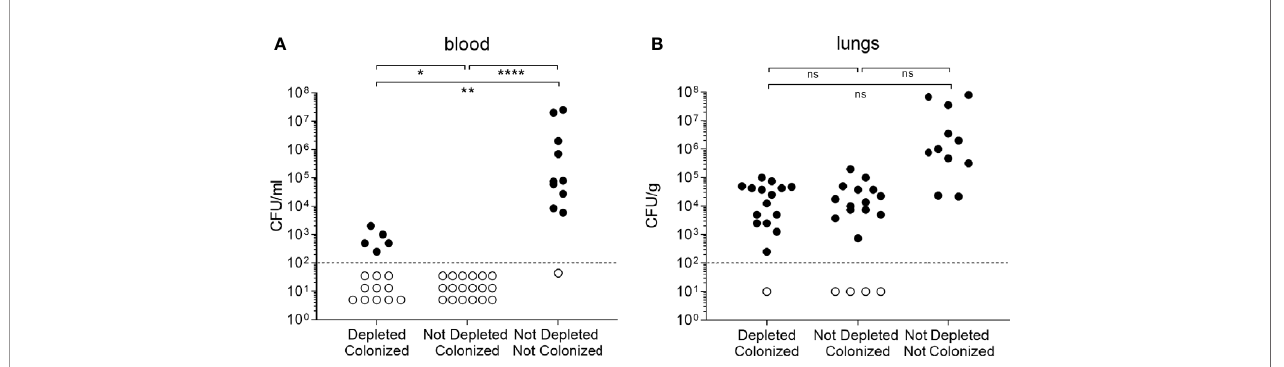
FIGURE 7 | B cell depletion effect on colonization. (A) CFU measured from blood of C57Bl/6 mice 24 h after intranasal infection with 6B strain. Mice were divided in three groups depending on the pre-infection treatment received: depleted colonized (n=16), not depleted colonized (n=18) and not depleted not colonized (n=11). At day 32, pneumococcal pneumonia was induced infecting intranasally the mice with 6B strain. (B) CFU measured from the same experiment in lungs homogenates. Error bars indicate standard deviations and Fisher ’ s exact test was used for statistical analysis (*P < 0.05, **P < 0.01, ****P